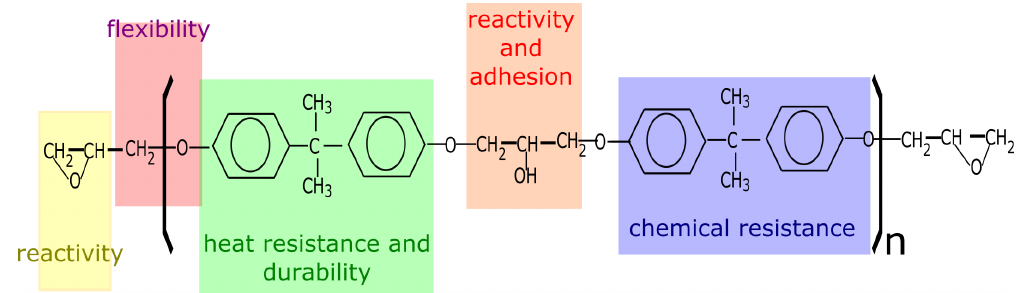
Figure 3. The structure and properties of an epoxy resin